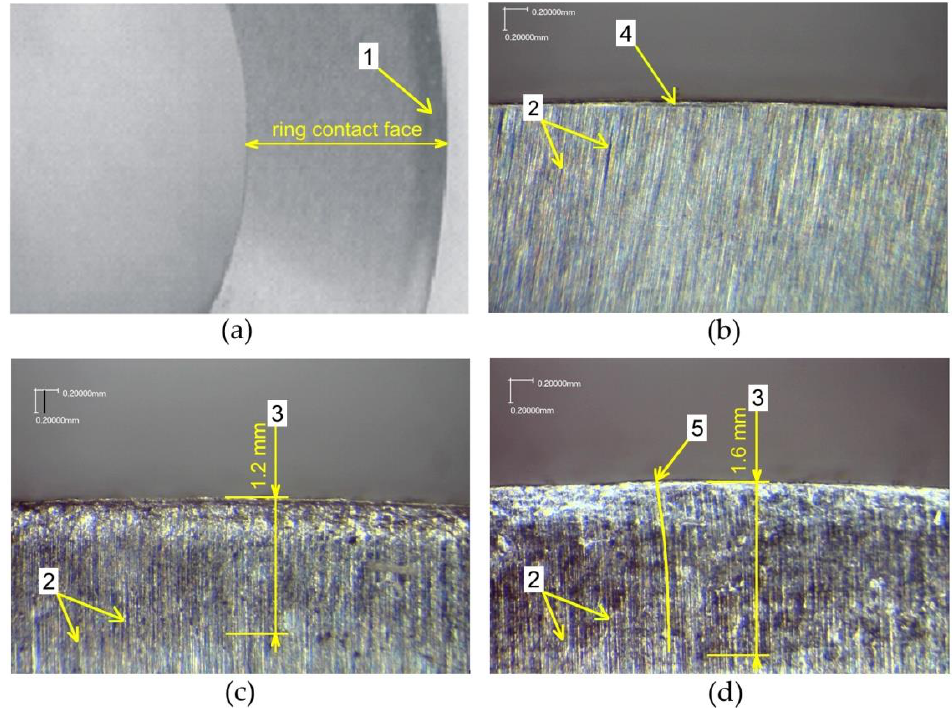
Figure 12. ( a ) End face of the burnished ring, ( b ) end face of the non-burnished ring, ( c ) end face of the burnished ring without braking torque, ( d ) end face of the burnished ring with braking torque of the roller: 1—plastically deformed zone, 2—grinding tracks, 3—depth of plastically deformed zone, 4—subsurface zone, 5—curving of grinding tracks.